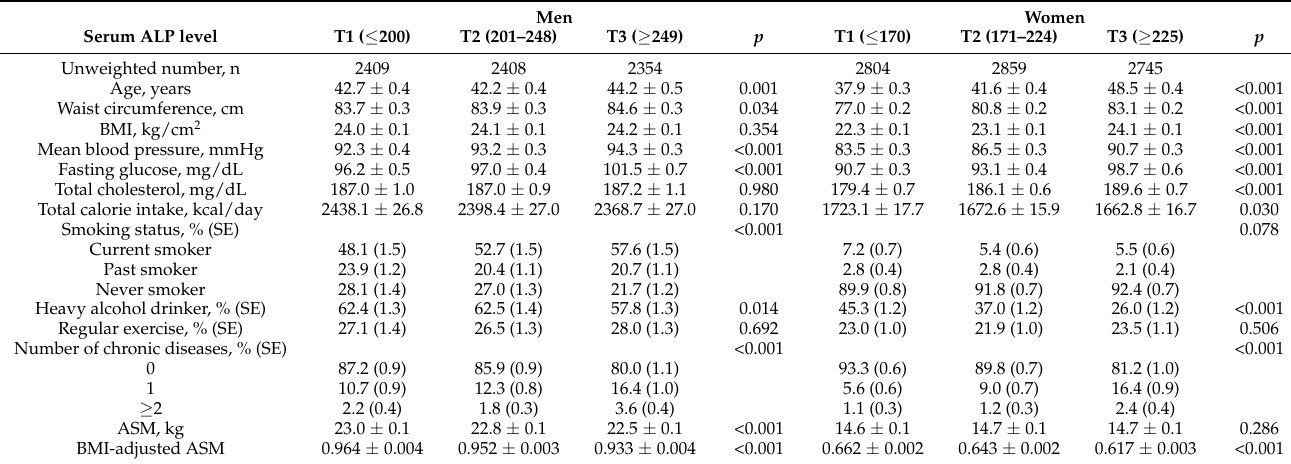
Table 1. Clinical characteristics of the study